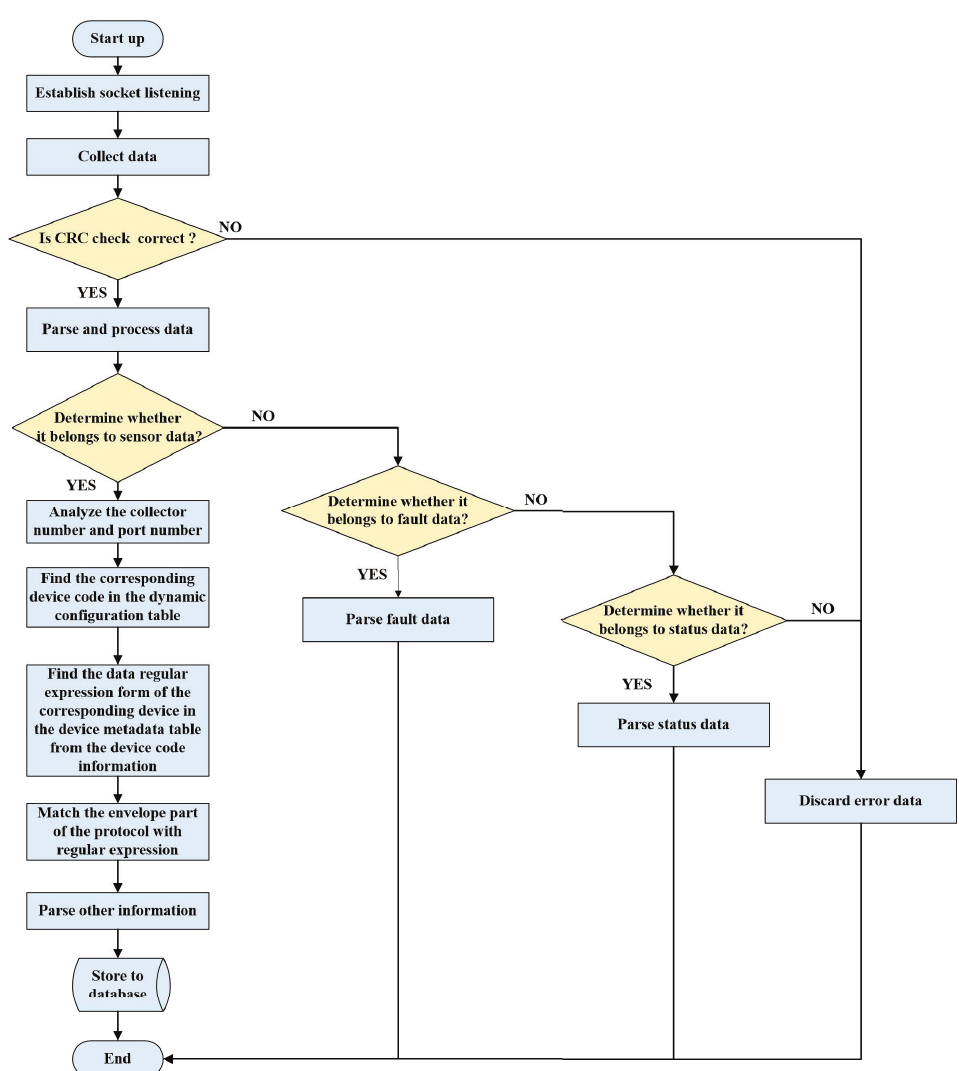
Figure 7. The flow chart of the dynamic management